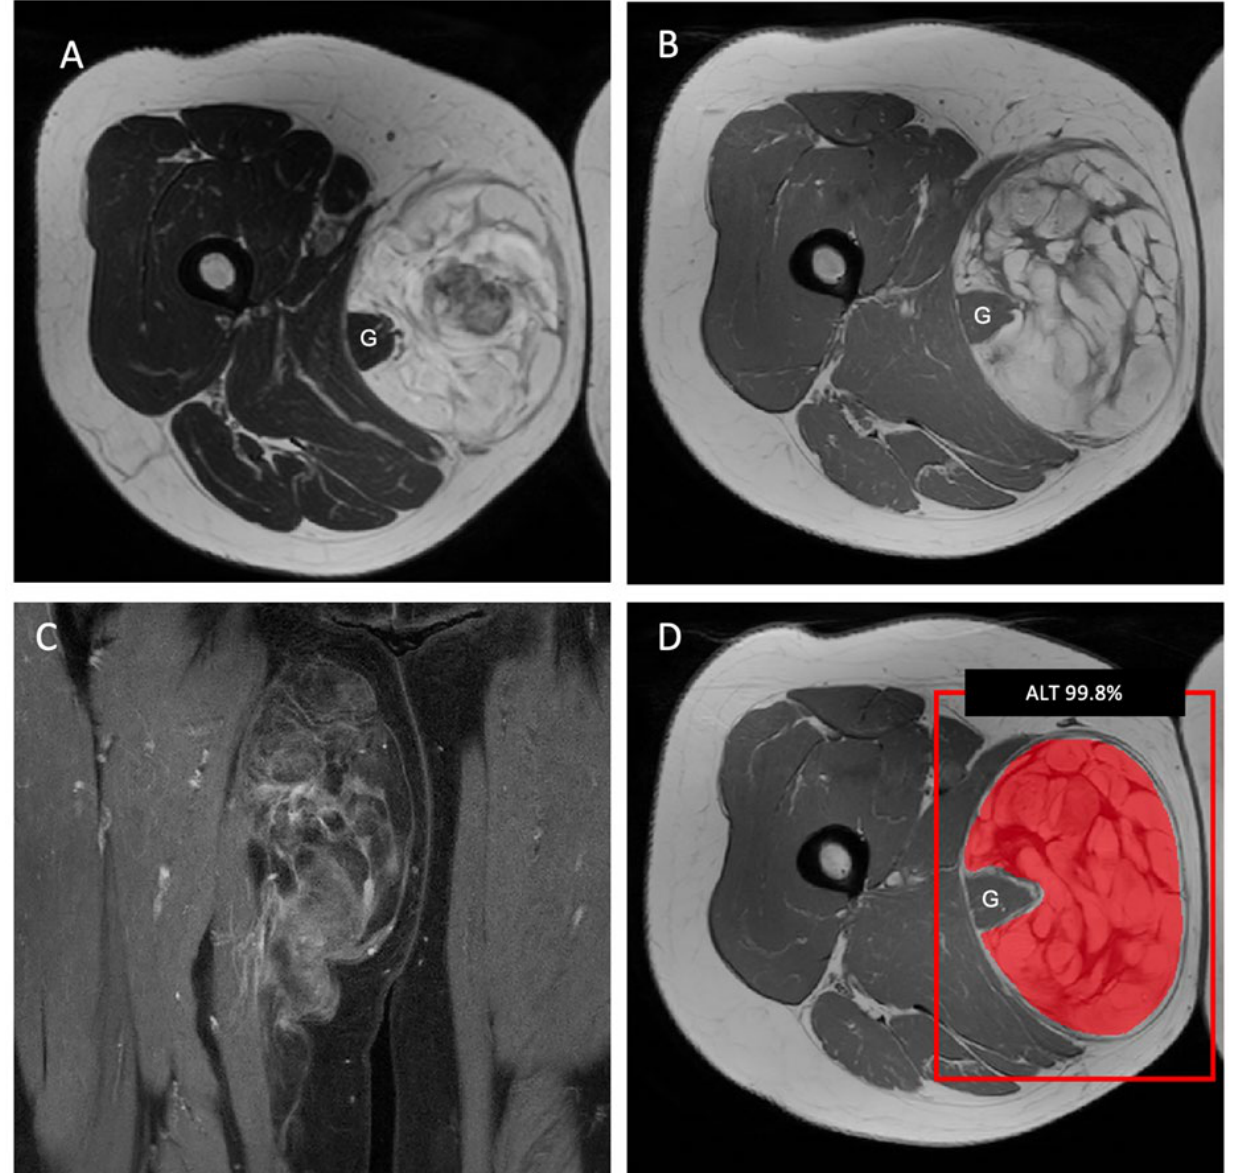
Figure 3. Lipomatous tumor in the medial right thigh, encasing the gracilis muscle (G). ( A ) The axial T2-weighted and ( B ) axial T1-weighted MR images show a large heterogeneous tumor with thick septa. ( C ) Septal contrast enhancement on the coronal T1-weighted images with fat saturation. ( D ) The machine-learning algorithm classified the tumor as an ALT with a probability of 99.8%. This diagnosis was confirmed by pathology and immunohistochemistry after surgical resection.